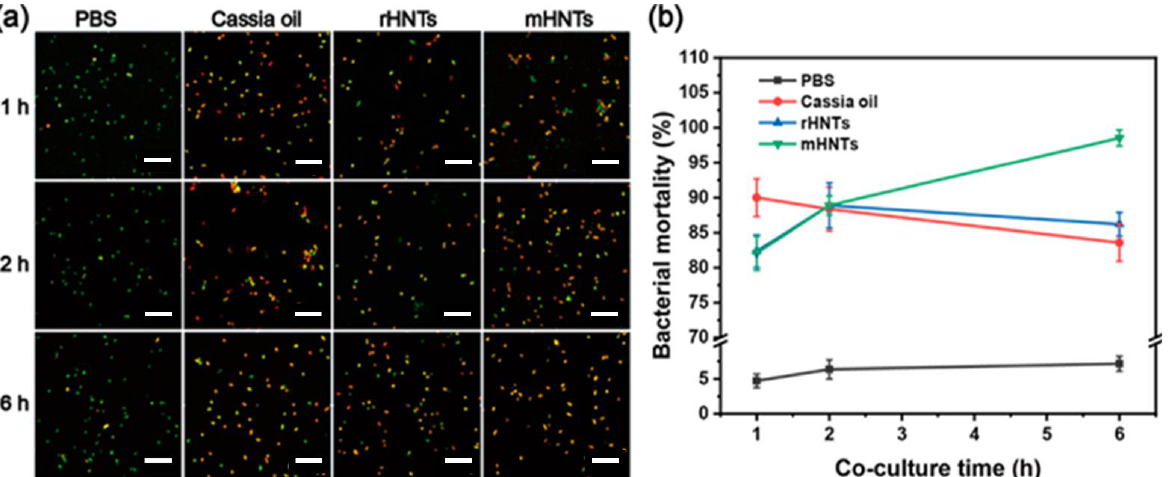
Figure 11. ( a ) Fluorescence images and ( b ) corresponding bacterial mortality data statistics of S. aureus co-cultured with different materials (PBS, cassia oil, rHNTs, and mHNTs). Scale bar 10 µ m. Reproduced with permission from [82].